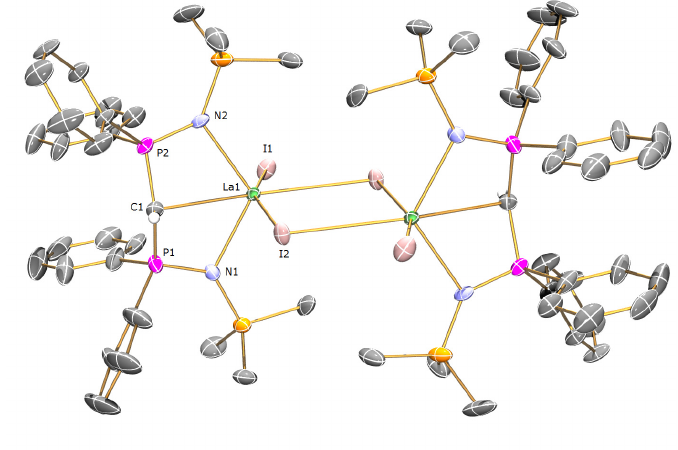
Figure 3. Molecular structure of 2 2C ellipsoids are drawn at 50% probability, with lattice solvent and non-methanide hydrogen atoms omitted for